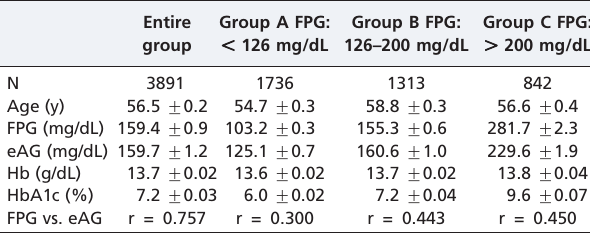
Table 1 - The levels of the glycemic parameters and the correlation coefficients for all groups (mean ¡ SEM).